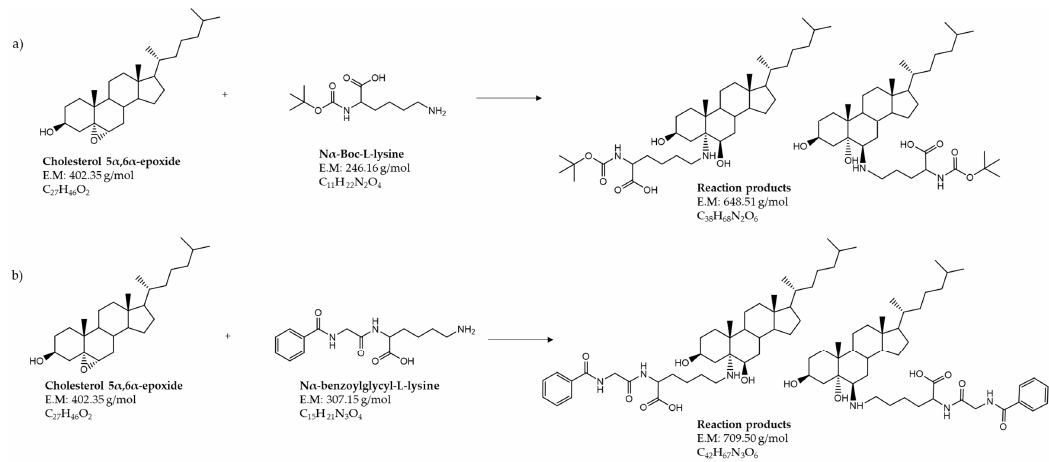
Figure 3. Proposed chemical reactions: ( a ) cholesterol 5 α ,6 α -epoxide and N α -Boc-L-lysine; ( b ) cholesterol 5 α ,6 α -epoxide and N α -benzoylglycyl- L -lysine. E.M: exact mass (g/mol).